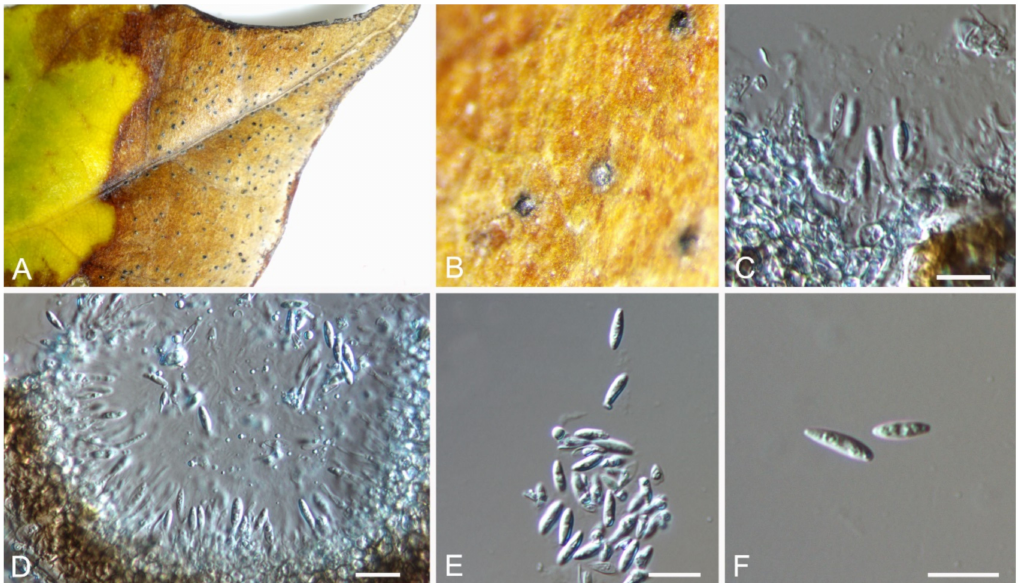
Figure 21. Diaporthe lithocarpi (BJFC-S1809). ( A , B ) Conidiomata on the diseased leaves of Castanea henryi ; ( C ) Conidiogenous cells giving rise to conidia; ( D ) Section through the pycnidium; ( E , F ) Conidia. Scale bars: ( C – F ) = 10 µ